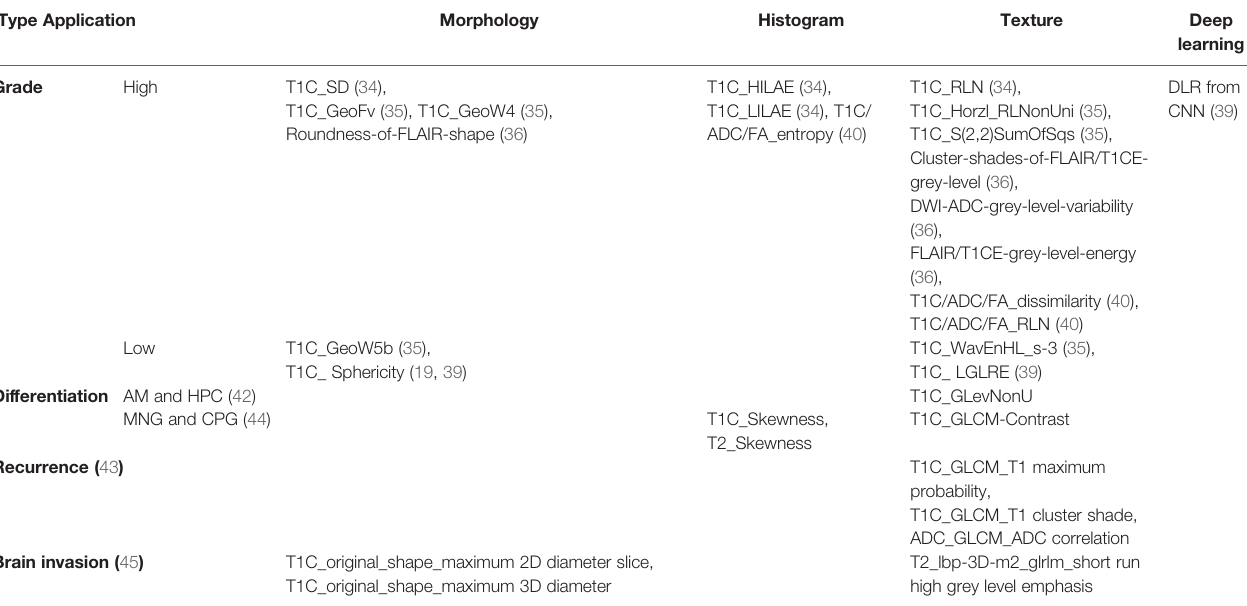
TABLE 2 | Summary of most useful set of radiomic features applied in grade prediction and other